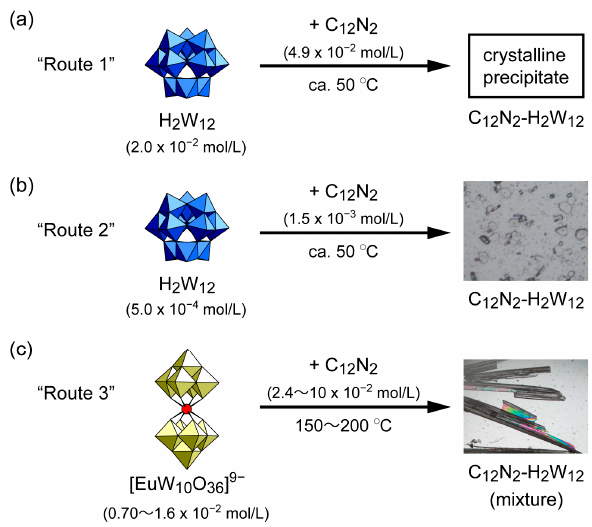
Scheme 1. Schematic representations of synthetic procedures for C 12 N 2 -H 2 W 12 hybrid crystals: ( a ) “Route 1”, an ion-exchange reaction using concentrated solutions; ( b ) “Route 2”, an